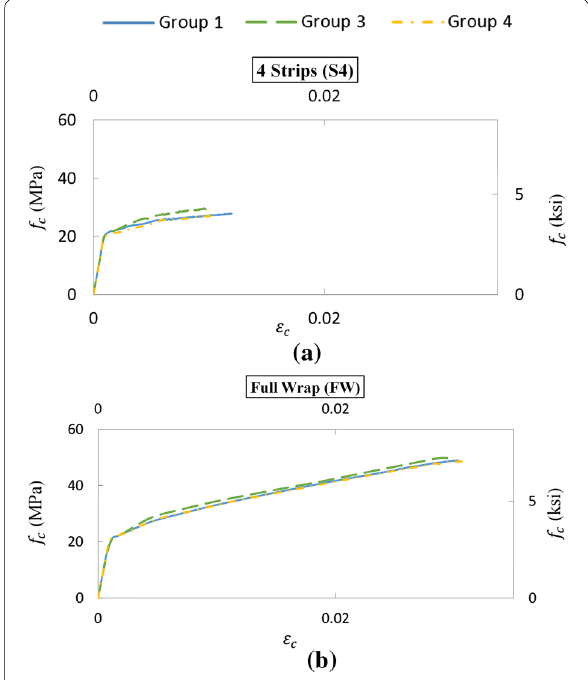
Fig. 6 Comparison of compressive stress ( f c ) versus axial strain (ε c ) for Groups 1, 3 and 4 (Table 2) for: a column with 4 Strips (S4 in Fig. 2) and b for column with Full Wrap (FW in Fig.